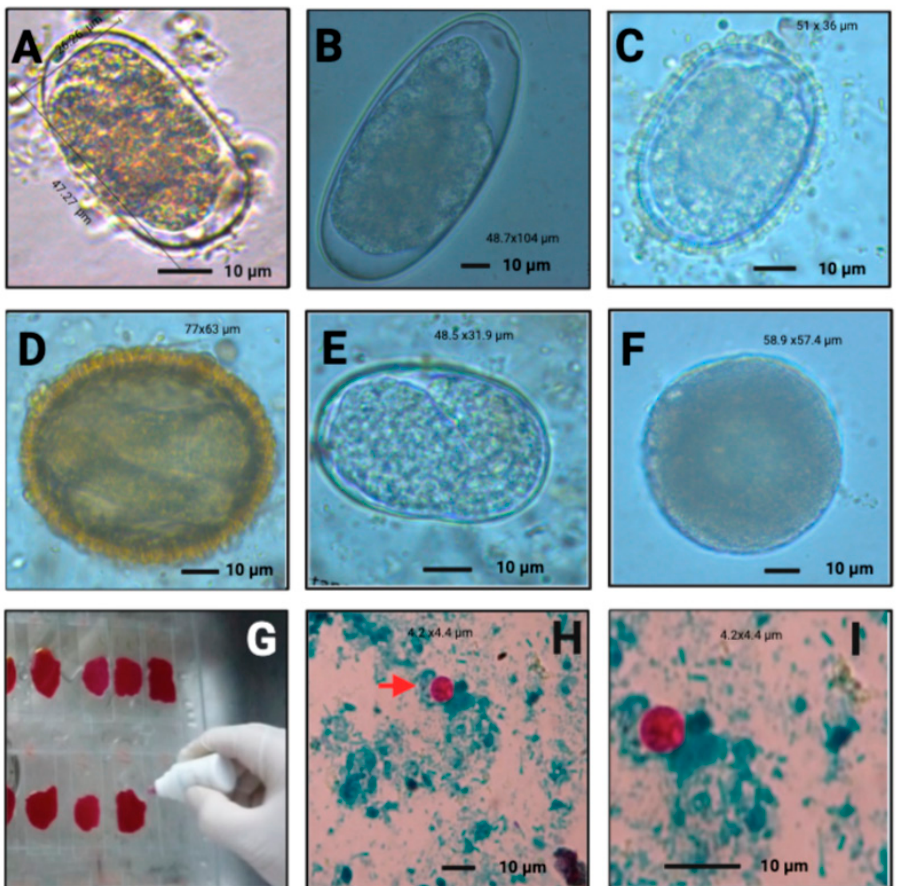
Figure 5. Eggs and cysts found in T ornatus . Ancylostoma spp. ( A ), Strongylus spp. ( B ); Ascaris spp. ( C ), Baylisascaris spp. ( D ), Strongyloides spp. ( E ), B. coli ( F ). Smear with carbon fuchsine exhibiting acid-fast staining Ziehl – Neelsen ( G ), Cryptosporidium oocysts 40 × ( H ) and 100 × ( I